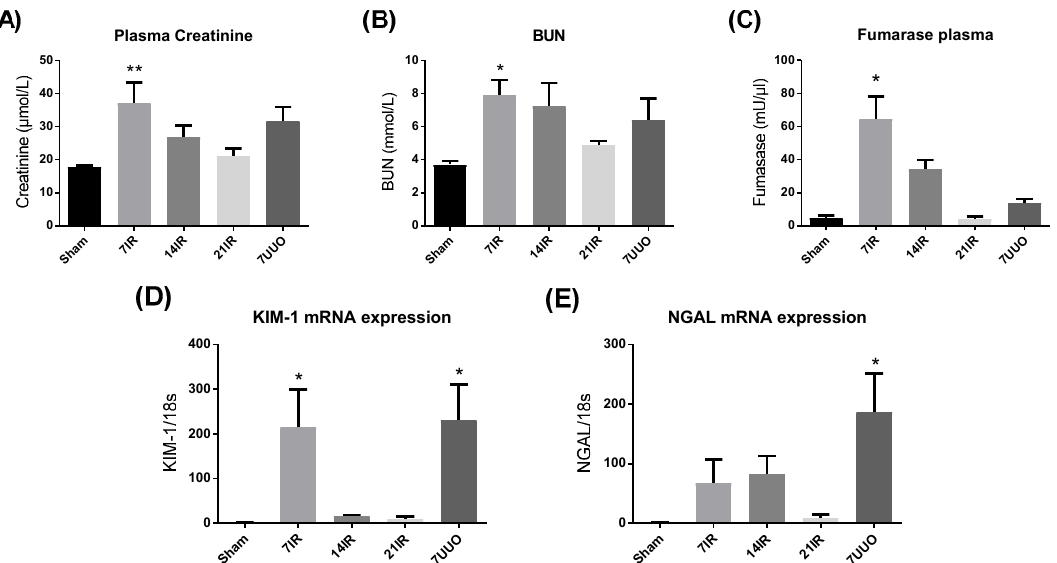
Figure 1. Kidney injury induction after ischemia reperfusion (IR) injury and unilateral ureteral obstruction (UUO): ( A ) plasma creatinine, ( B ) blood urea nitrogen (BUN), ( C ) fumarase activity, ( D ) kidney injury molecule-1 (KIM-1) mRNA expression corrected for 18S ribosomal protein, and ( E ) neutrophil gelatinase-associated lipocalin (NGAL) mRNA expression corrected for 18S ribosomal protein. ANOVA with Bonferroni multiple comparison test was performed between sham, ischemia-reperfusion injury (IRI) and UUO. Each bar represents the mean ± SEM, * p < 0.05 compared to sham group ( n = 6). ** p < 0.01 compared to sham group. 7IR : 7 days of reperfusion ( n = 6), 14IR : 14 days of reperfusion ( n = 4), 21IR : 21 days of reperfusion ( n = 5), and 7UUO : 7days UUO model ( n = 6).